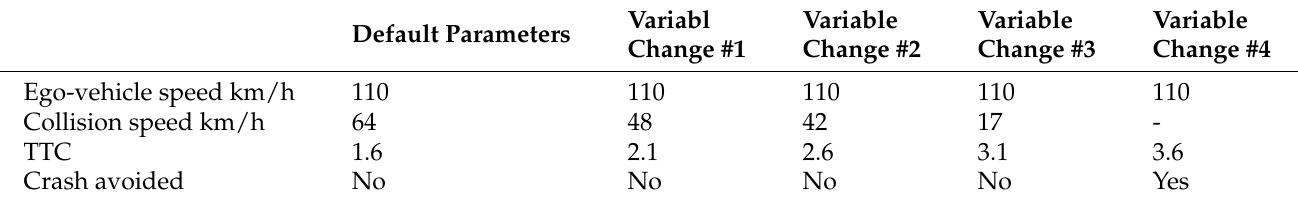
Table 3. Speed profiles of ego-vehicle. Coefficient of rolling friction 0.02 and 0.04.